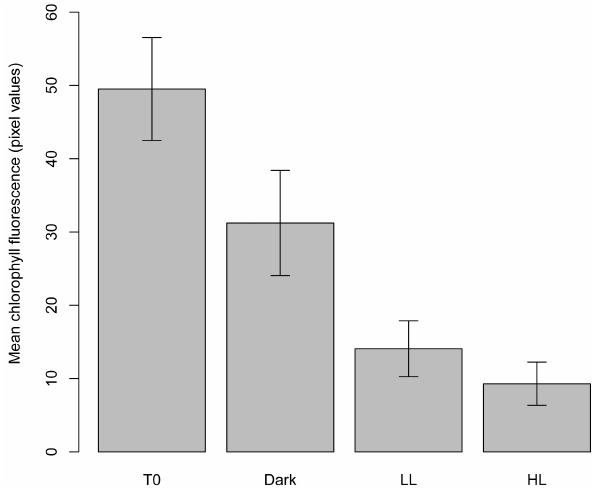
Figure 3. Mean chlorophyll a fluorescence ( ± SE, n = 30) at the end for the three experimental conditions (Dark, Low Light and High Light) and the beginning (T0) of the experiment using Haynesina germanica . Higher mean values likely corresponded to foraminifera containing more chlorophyll.